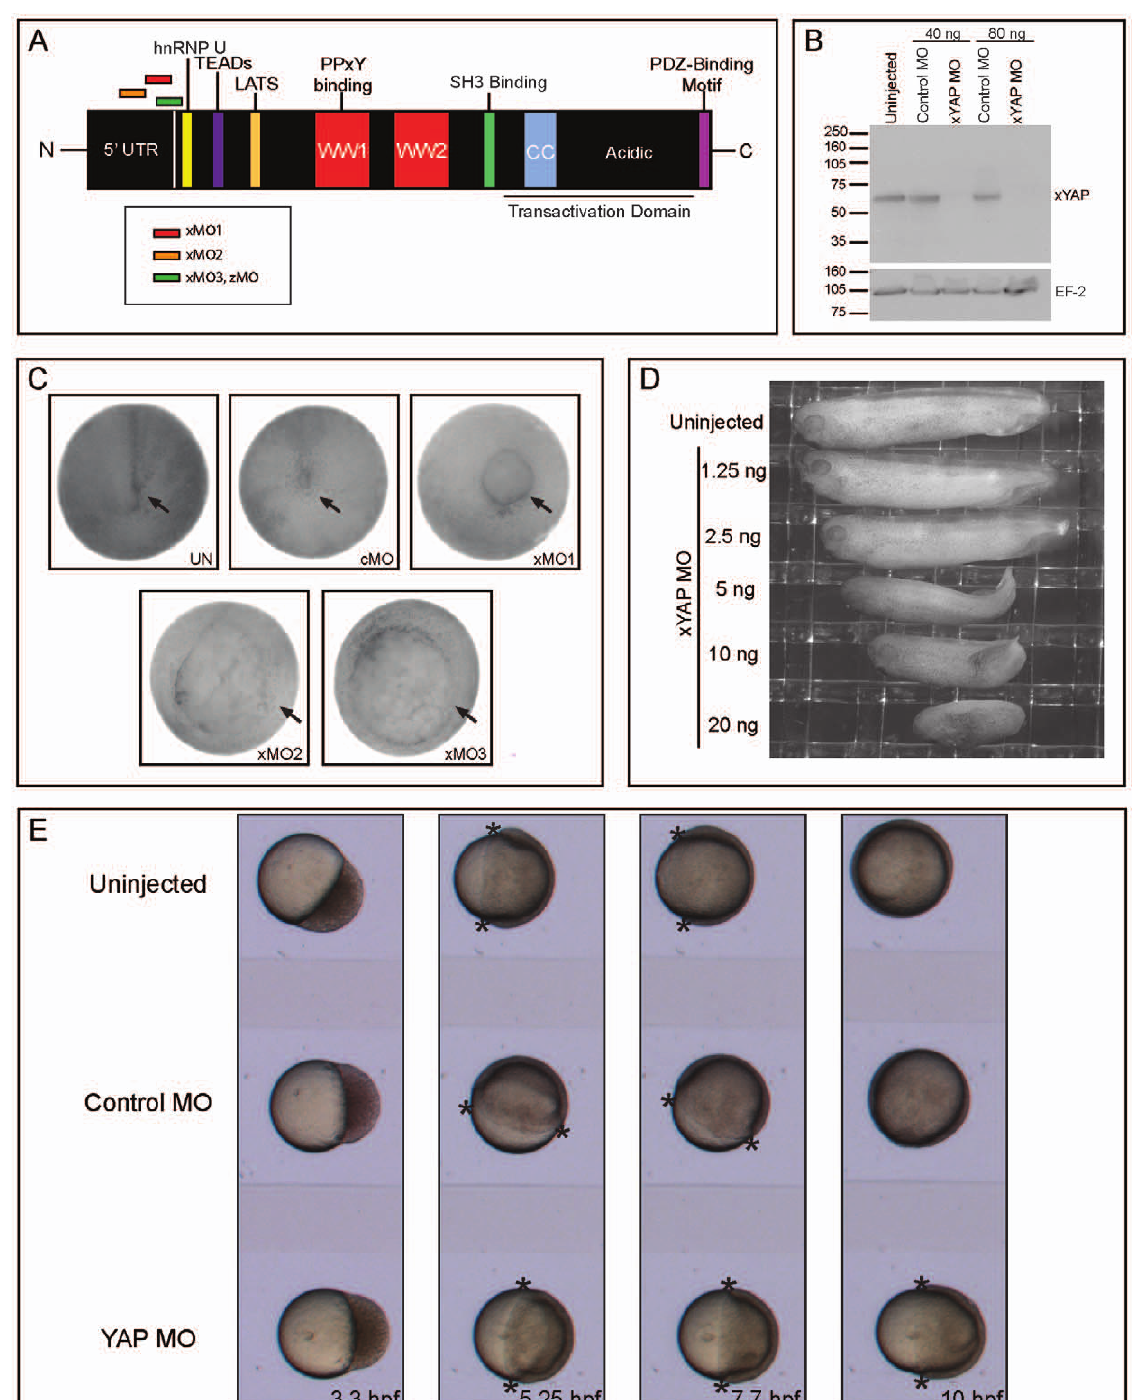
Figure 1. YAP morphant embryos exhibit defects in A-P axis elongation. ( A ) Frog and zebrafish YAP possess the ascribed functional and protein-protein interaction domains, including the TEAD-binding site (purple), the LATS phosphorylation site (orange), the two WW domains (red) that allow for PPxY binding, the Src Homology 3 (SH3)-binding domain (green), the coiled-coil region (blue), the transactivation domain (underline), and the PDZ-binding motif (pink). hnRNP U (yellow) binding has only been experimentally tested with human YAP, but related sites are in the fish and frog proteins. This diagram also illustrates the relative location of Xenopus laevis (x) and Danio rerio (z) MO-binding sites. ( B ) Injection of an equimolar cocktail of all three xYAP MOs at two concentrations (40 ng and 80 ng) resulted in efficient knockdown of endogenous, zygotic xYAP protein in stage 15 embryos as measured by western blot analysis. EF-2 expression from the same blot served as the loading control. ( C ) Three different xYAP MOs (80 ng; see A for binding sites) resulted in failed closure of the blastopore (arrows). ( D ) Reducing the concentration of the xYAP MO cocktail (left side) allowed blastopore closure, but resulted in dose-dependent A-P axis shortening. ( E ) Time-lapse video microscopy showed that zYAP MO (16 ng) injected embryos also exhibit perturbation in the completion of gastrulation. Asterisks mark the tissue front of epiboly movements. In uninjected and cMO-injected embryos, this front completely envelops the yolk by 10 hours post-fertilization (hpf). These fronts are still in the equatorial region in the 7.7–10 hpf YAP MO-injected embryos. doi:10.1371/journal.pone.0020309.g001 PLoS ONE |